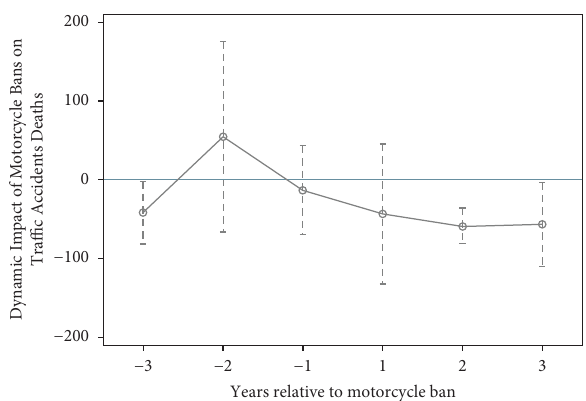
Figure 7: The dynamic impact of motorcycle bans on traffic accident deaths.